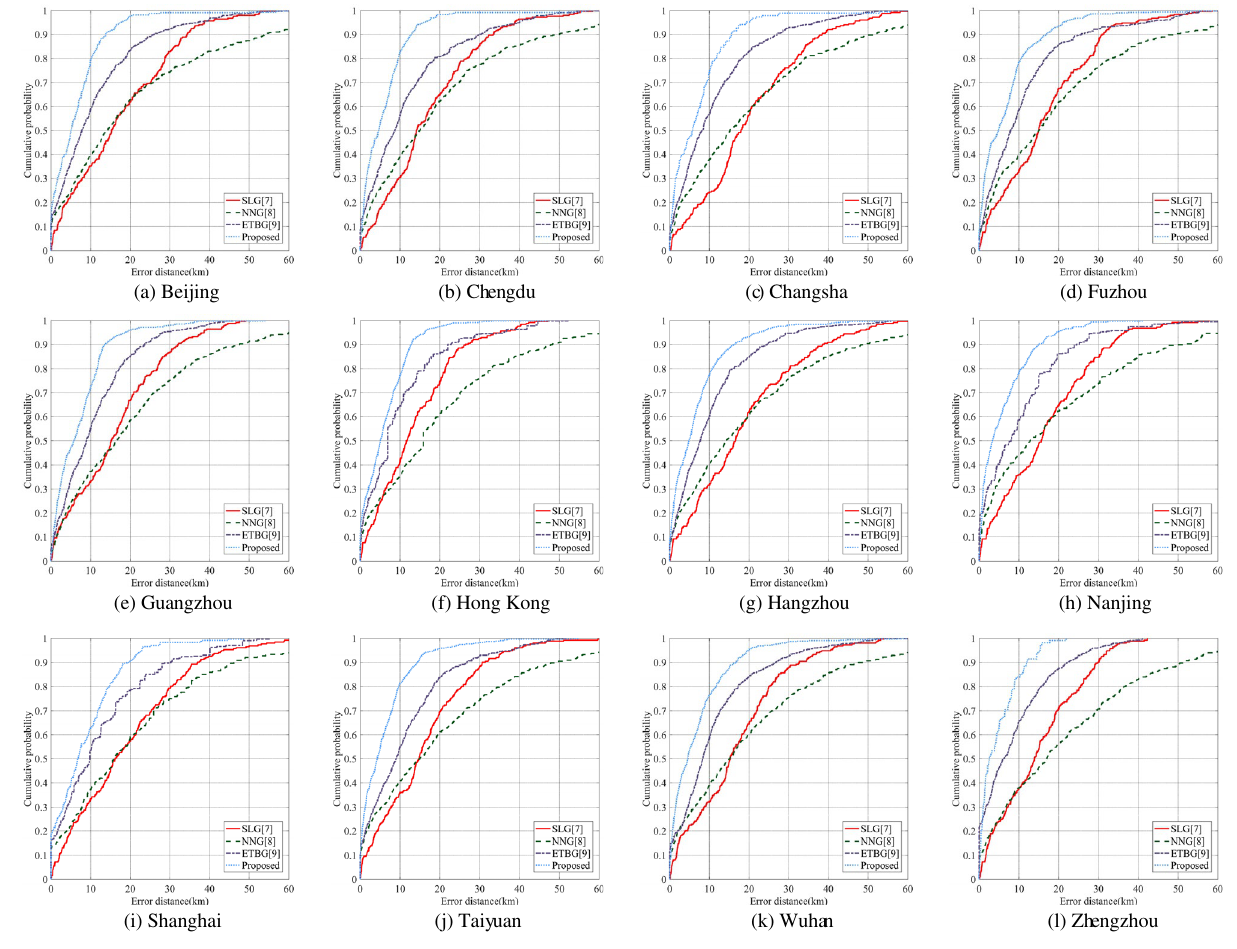
Figure 5. Comparison of street-level geolocation capability.